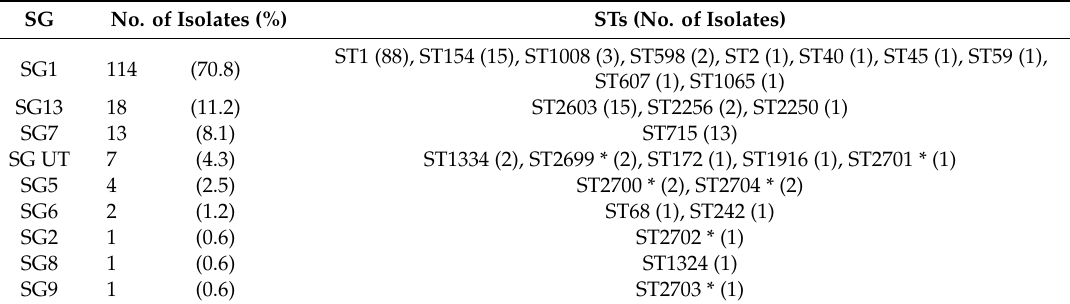
Table 1. Distribution of SGs and STs of 161 L. pneumophila isolated in cooling tower, Kobe, Japan form